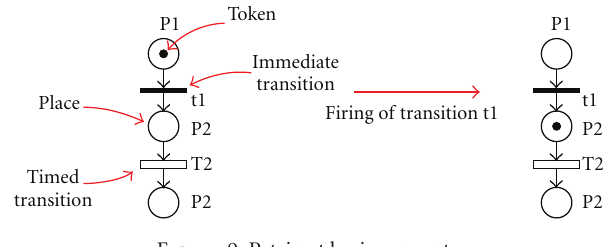
Figure 9: Petri net basic